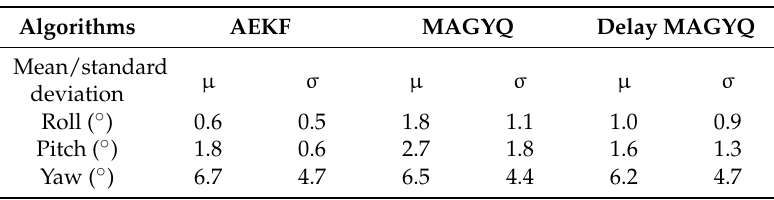
Table 1. Angular errors of AEKF, MAGYQ and Delay MAGYQ attitude estimation filters for the texting scenario with all four subjects.